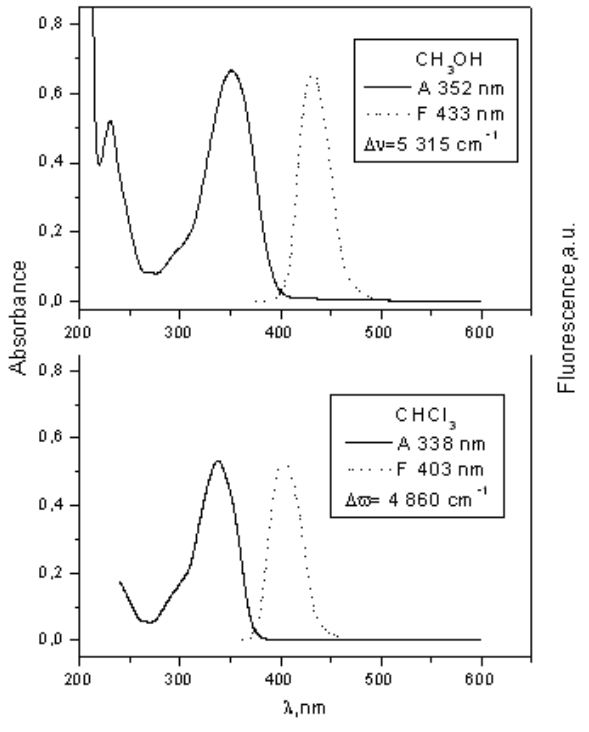
Figure 4 . Absorption and fluorescence spectra of 8 in chloroform and methanol at 10 − 5 mol dm − 3 .